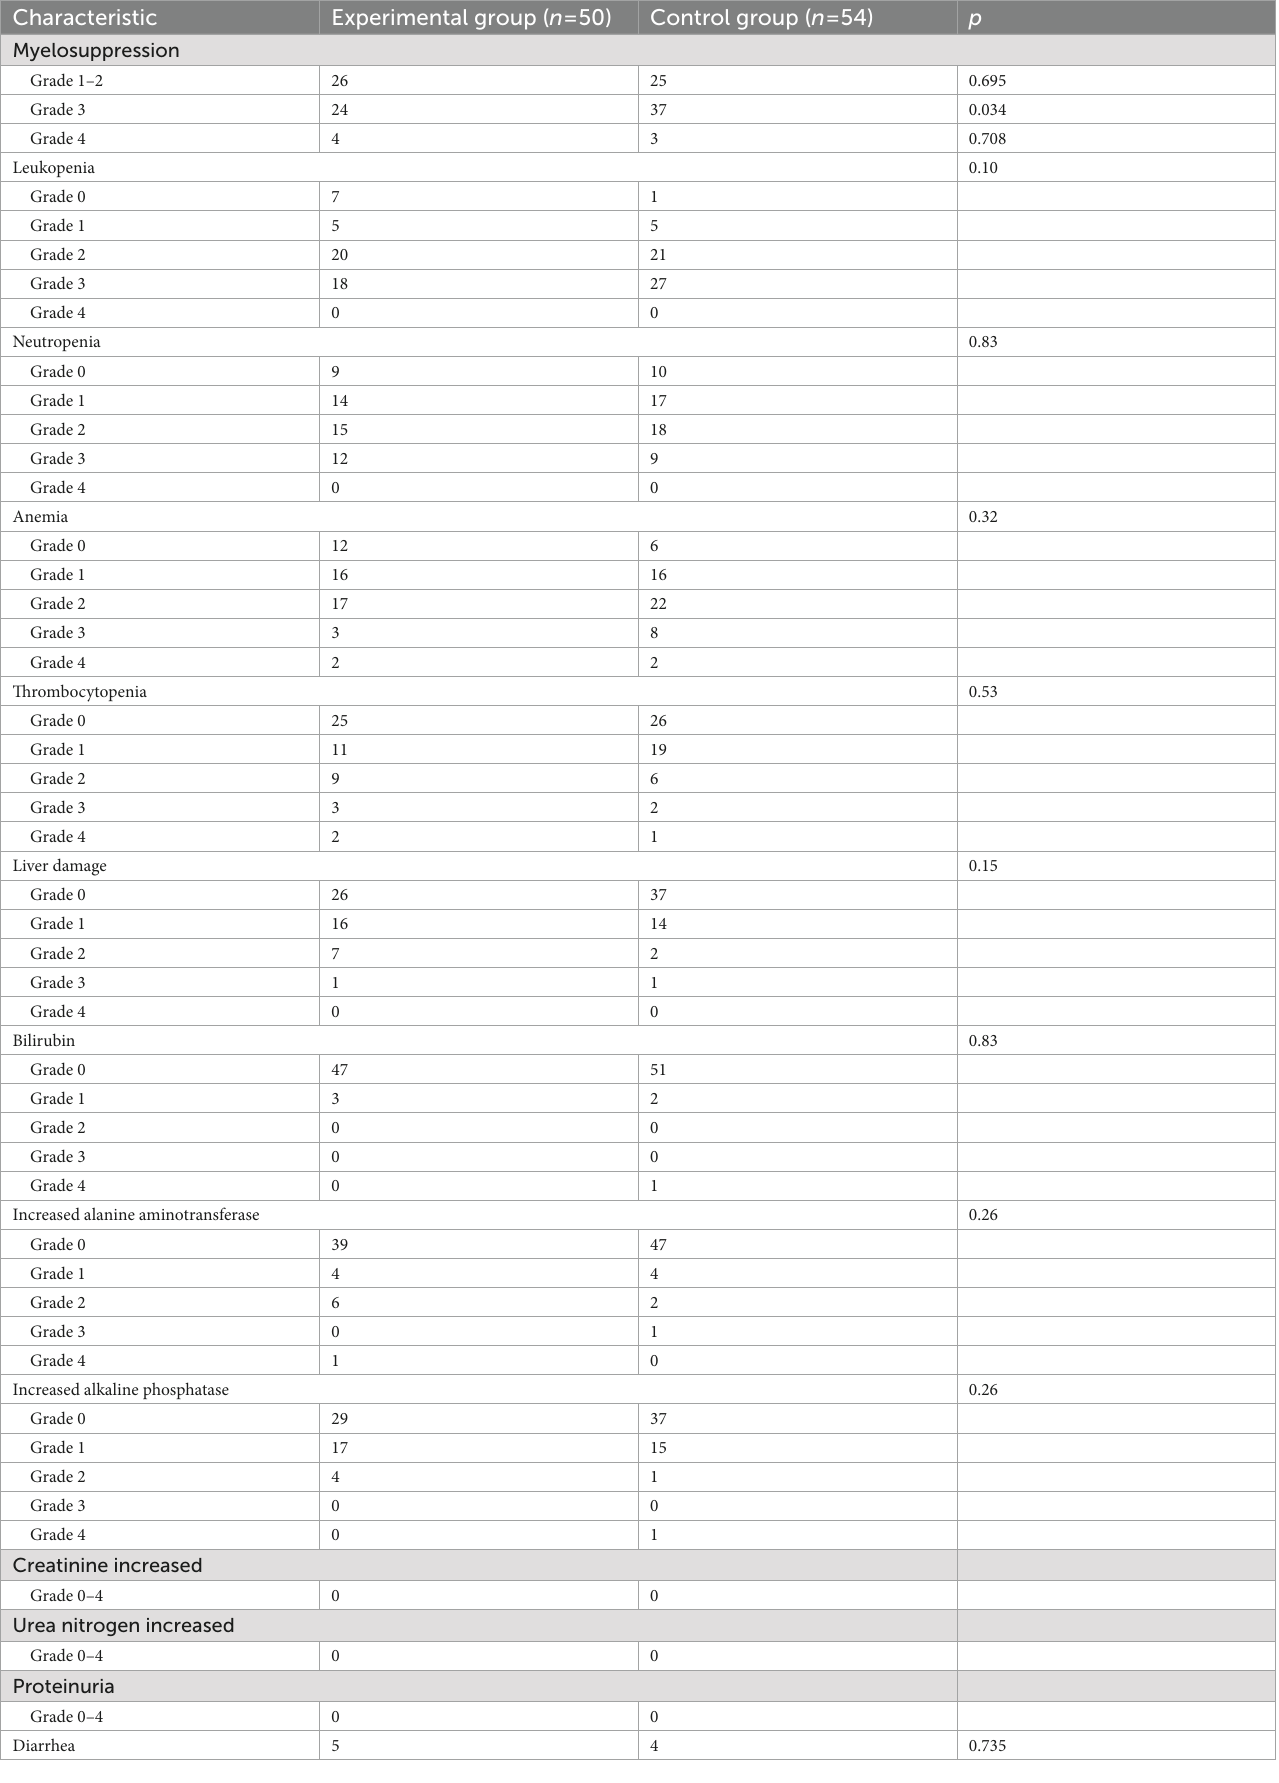
TABLE 2 Adverse events with concurrent chemoradiotherapy. Characteristic Experimental group ( n = 50) Control group ( n = 54)